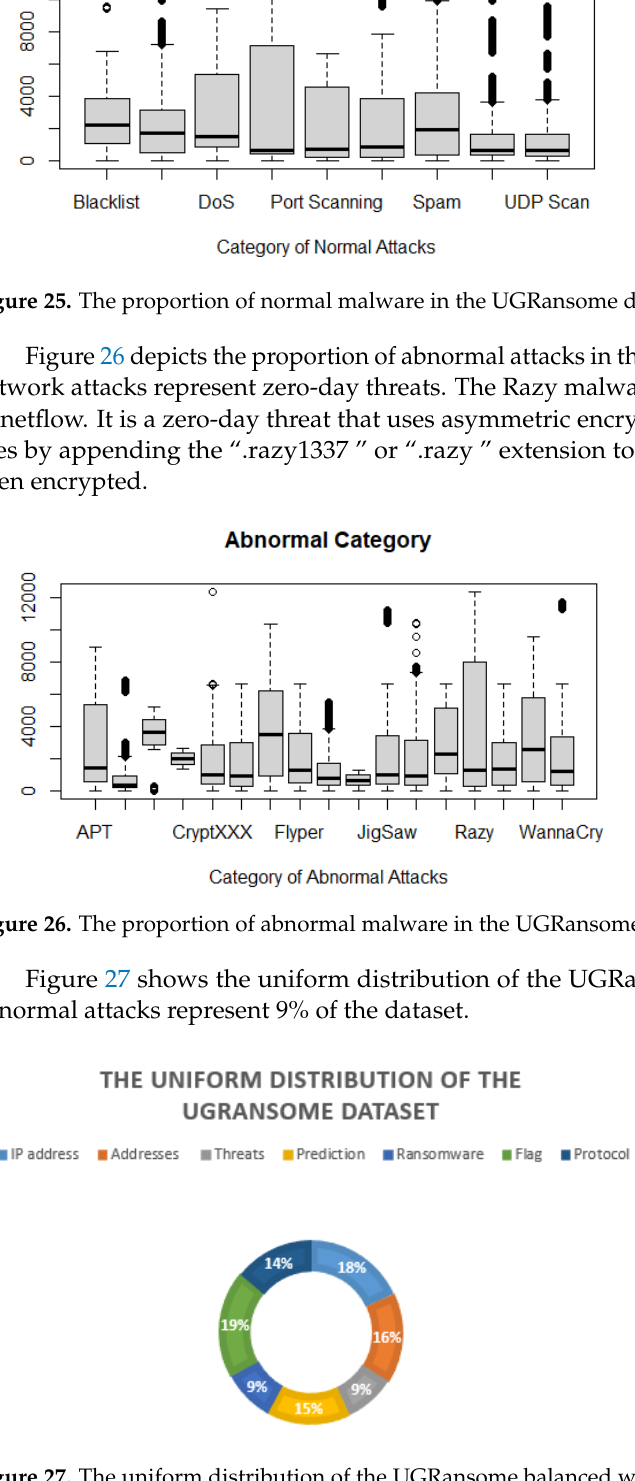
Figure 27. The uniform distribution of the UGRansome balanced with 9% of normal or well-known threats and 9% of abnormal or unknown threats